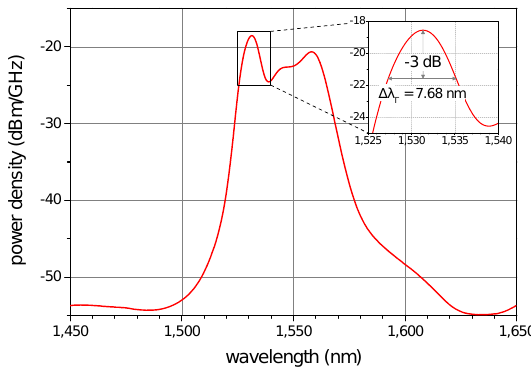
Figure 4. The output spectrum of the broadband superfluorescent fiber source utilized in the I-FOG setup (measured before the